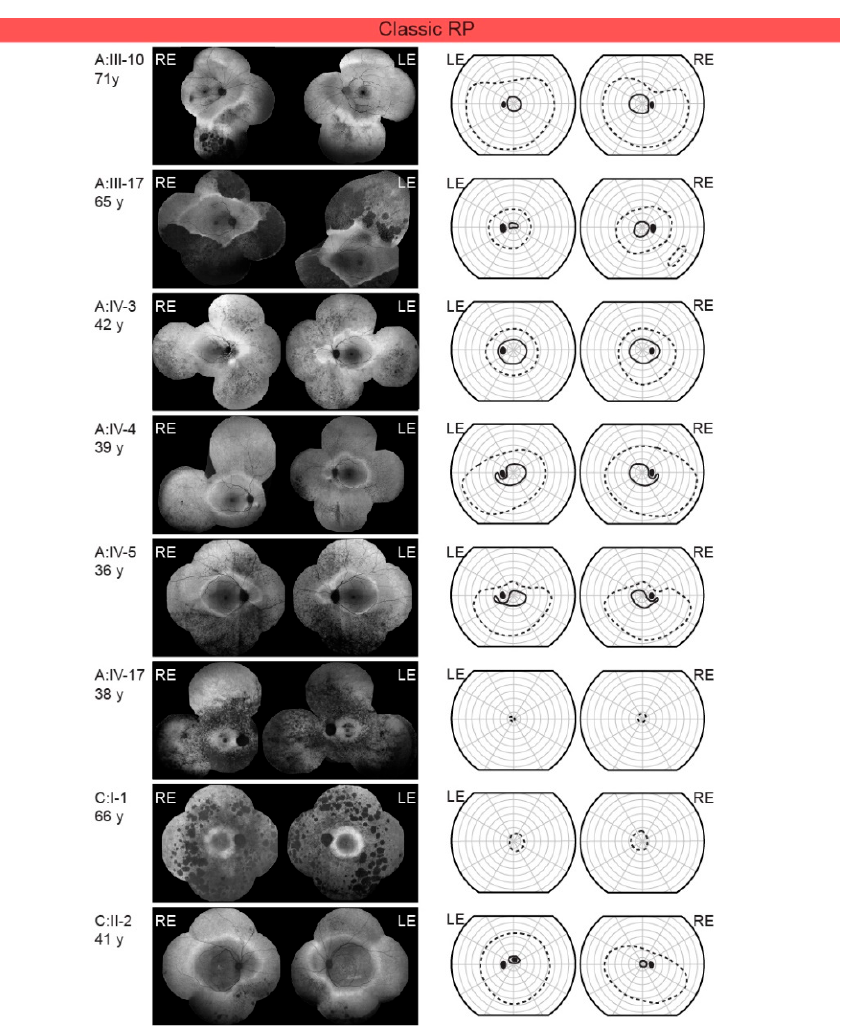
Figure 5. Fundus autofluorescence and Goldmann visual field in RHO p.G90D patients diagnosed with classic retinitis pigmentosa (RP). Patient ID and age are stated on the left of each row. The full and dashed lines represent the II/1 (dim target) and II/4 (bright target) isopters, respectively. Abbreviations: RP—retinitis pigmentosa; RE—right eye; LE—left eye .